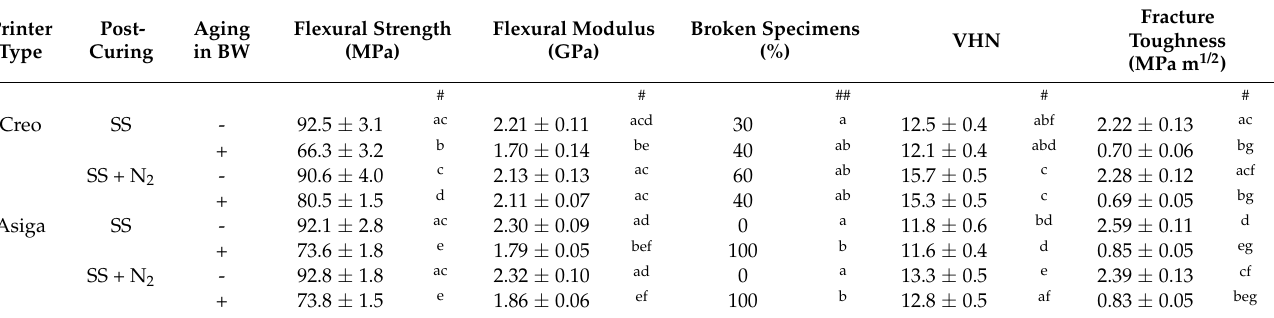
Table 2. Mean value and standard deviation of flexural strength, flexural modulus, ratio of broken specimens during three-point bending test, VHN, and fracture toughness, and results of one-way ANOVA statistical analysis and Chi-squared